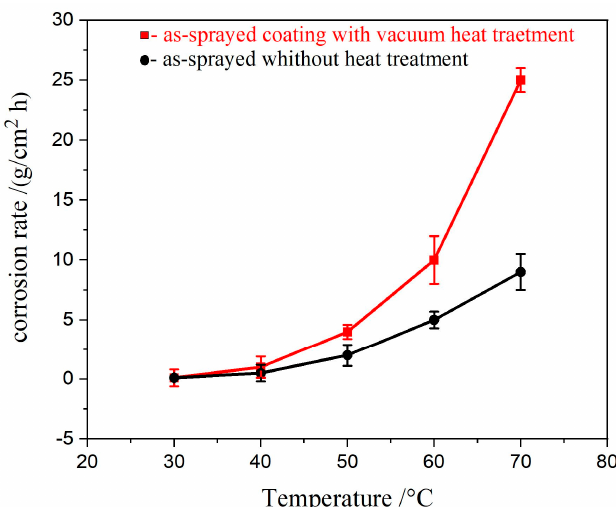
Figure 5. Relationship between temperature and corrosion rate of as-sprayed coating with vacuum heat treatment at 650 °C and as-sprayed coating without heat treatment.